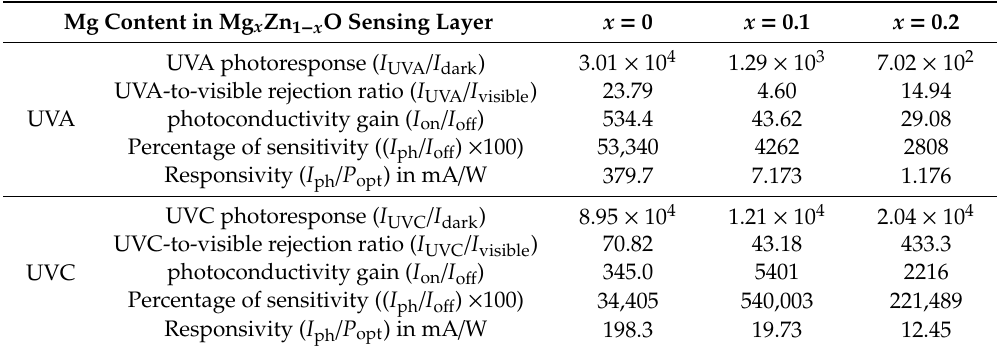
Table 2. Summary of the photoconductive properties of MSM photodetectors based on sol-gel derived Mg x Zn 1 − x O thin